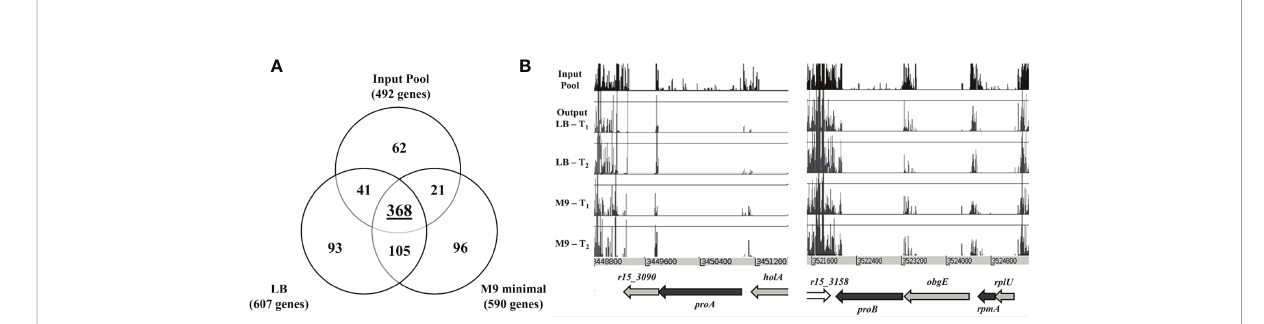
FIGURE 4 (A) Venn diagram presenting the number of B. pseudomallei genes classi fi ed as essential in (1) initial input pool, (2) nutrient-rich LB media and (3) nutrient-depleted M9 minimal media. (B) Insertion pro fi les of B. pseudomallei R15 genomic regions r15_3090 − r15_3091 and r15_3158 − r15_3162 taken from initial input pool (black) and output pools: LB-T 1 , LB-T 2 (blue), M9-T 1 and M9-T 2 (red). Genes are indicated by arrows, with color coding for gene essentiality: grey, essential genes; black, “ general ” conditional-essential genes required for in vitro growth; white, non- essential